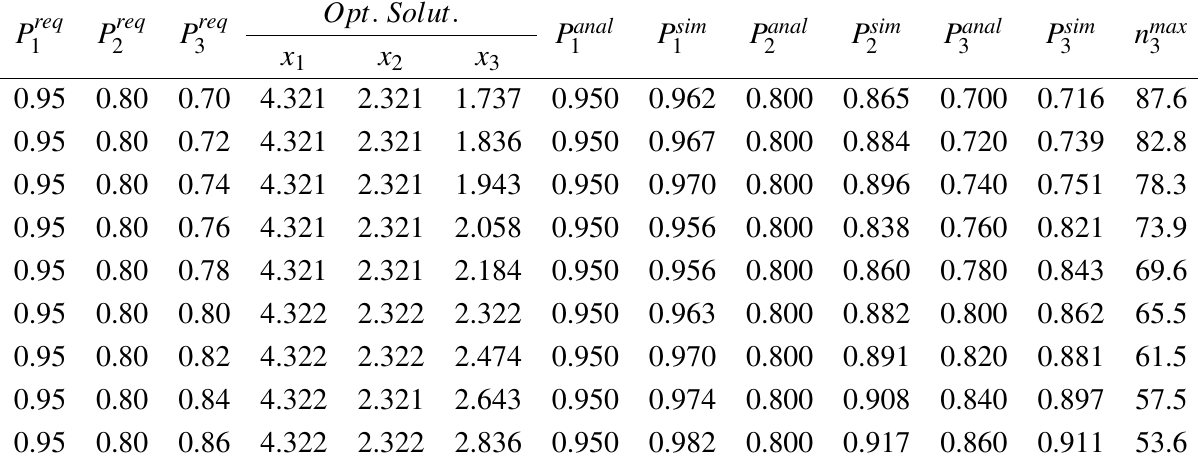
Table 2. The effects of the PDR requirement for class Q interior-point algorithm, and the maximum number of nodes in class Q = 0 : 95, p n = 15, p = 2 1 2